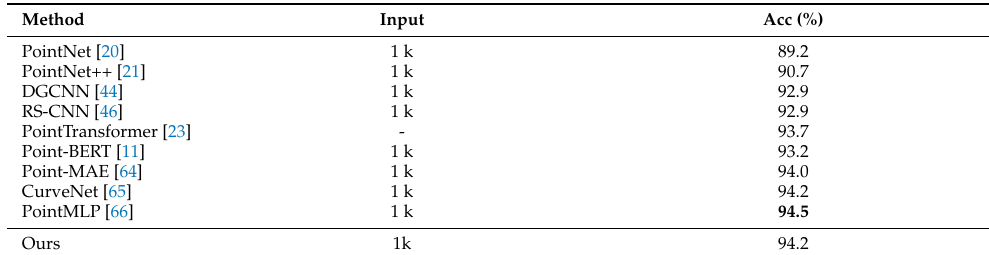
Table 6. Comparison with other supervised methods on ModelNet40 dataset. The bold denotes the best performance.